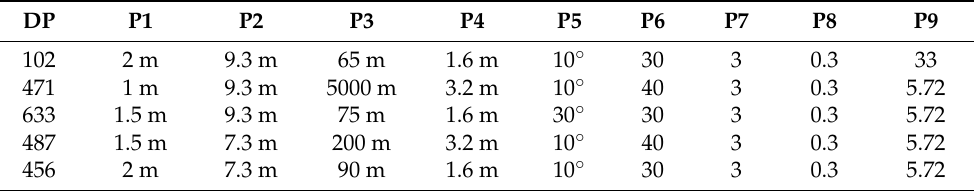
Table 10. SERN DP102 overall performance at each